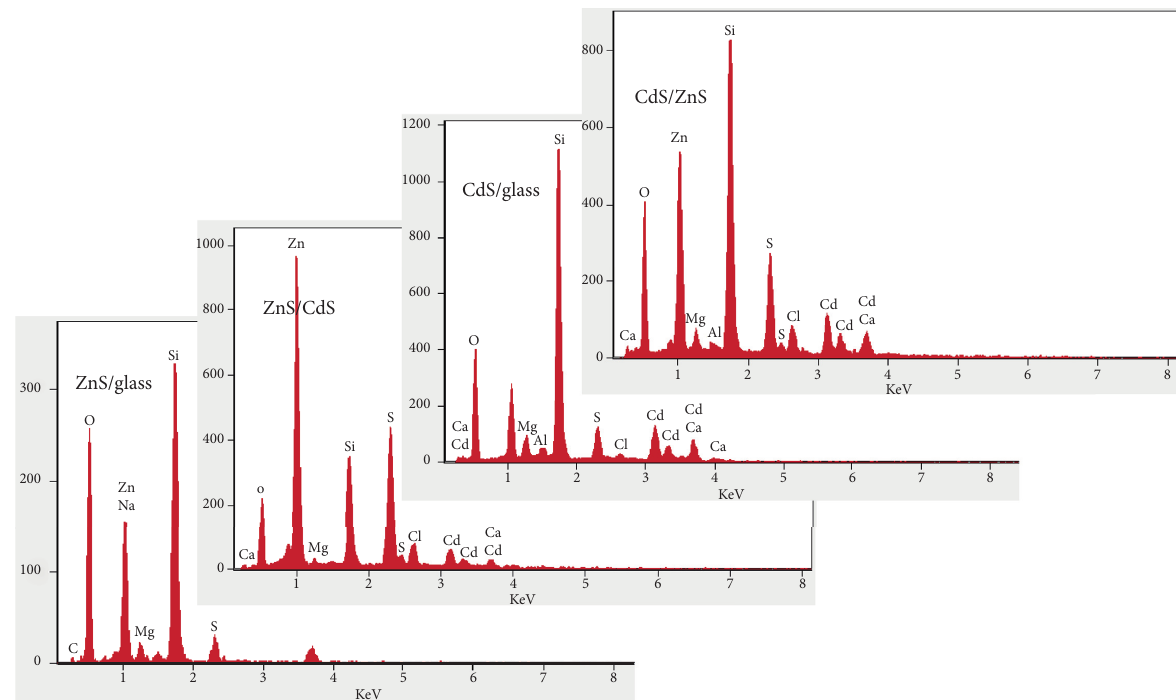
Figure 7: EDAX spectrum of the ZnS/glass, ZnS/CdS, CdS/glass, and